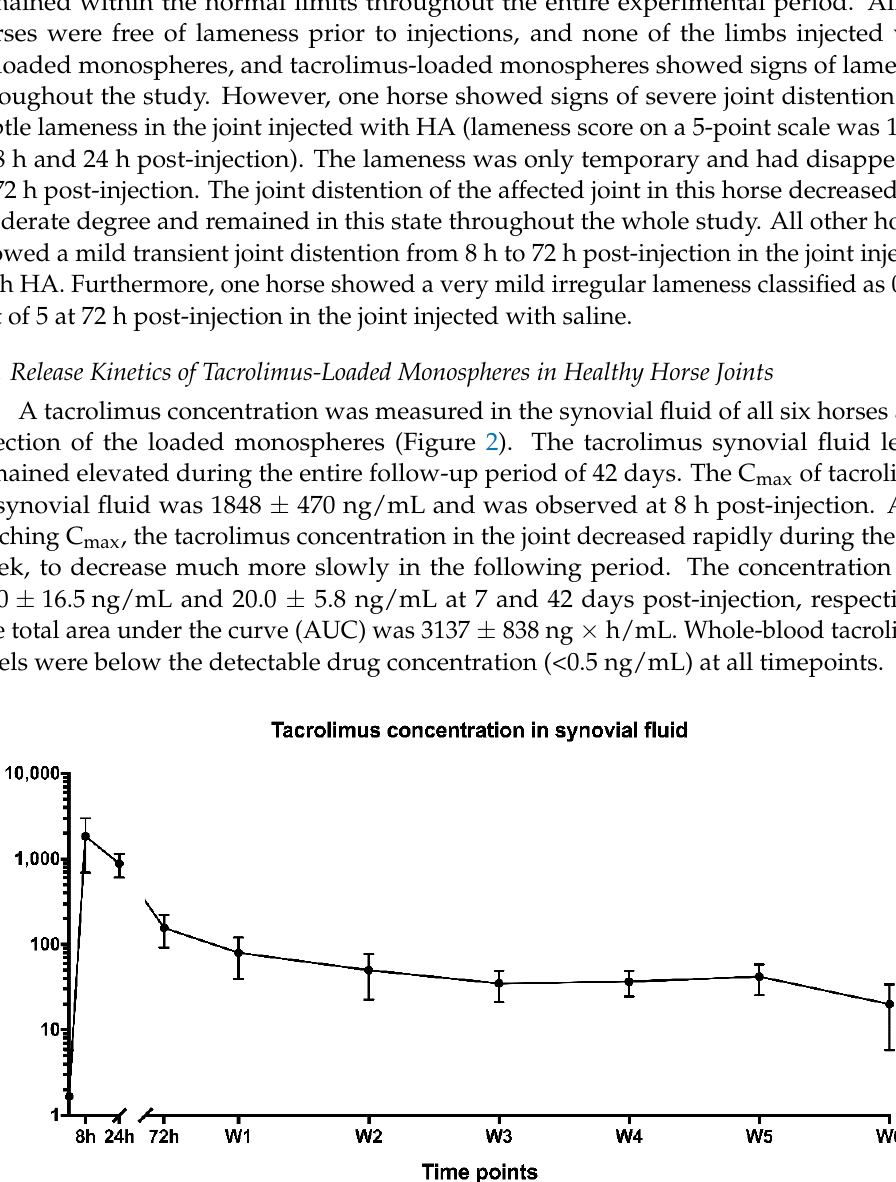
Figure 2. Tacrolimus concentrations in synovial fluid after the intra-articular administration of Tacrolimus loaded in [PDLA-PEG 1000 ]- b -[PLLA] multiblock copolymers over a 6-week (W1–W6) period. Graph shows the mean ± SD.